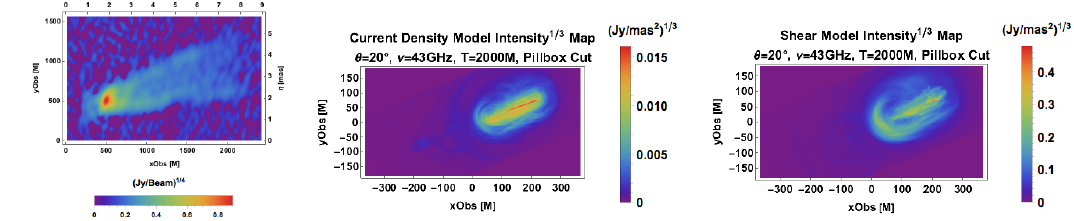
Figure 7. M87 VLA observation ( left ) at 43 GHz. The total intensity is monotonically transformed by ( · ) 1/4 for visual clarity. The beam dimensions are 4.3 × 10 − 4 arcs · 2.1 × 10 − 4 arcs. Synthetic 43 GHz observations are shown for comparison using the current density ( middle ) and shear ( right ) models and transformed by ( · ) 1/3